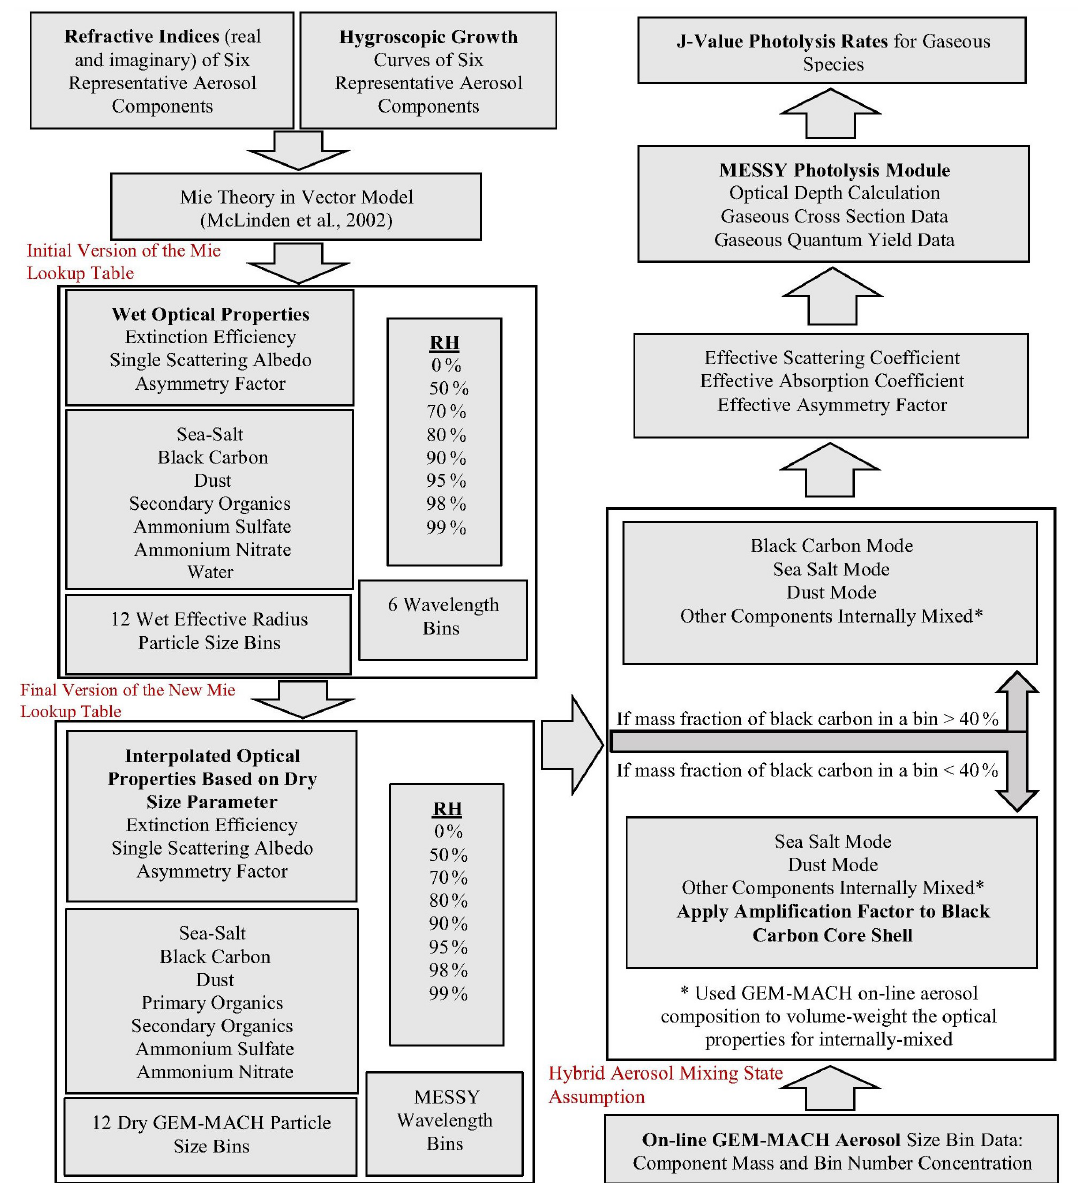
Figure 1. Steps and methods in calculating the new Mie lookup table for photolysis rates in GEM-MACH. RH represents the relative humidity and λ is the